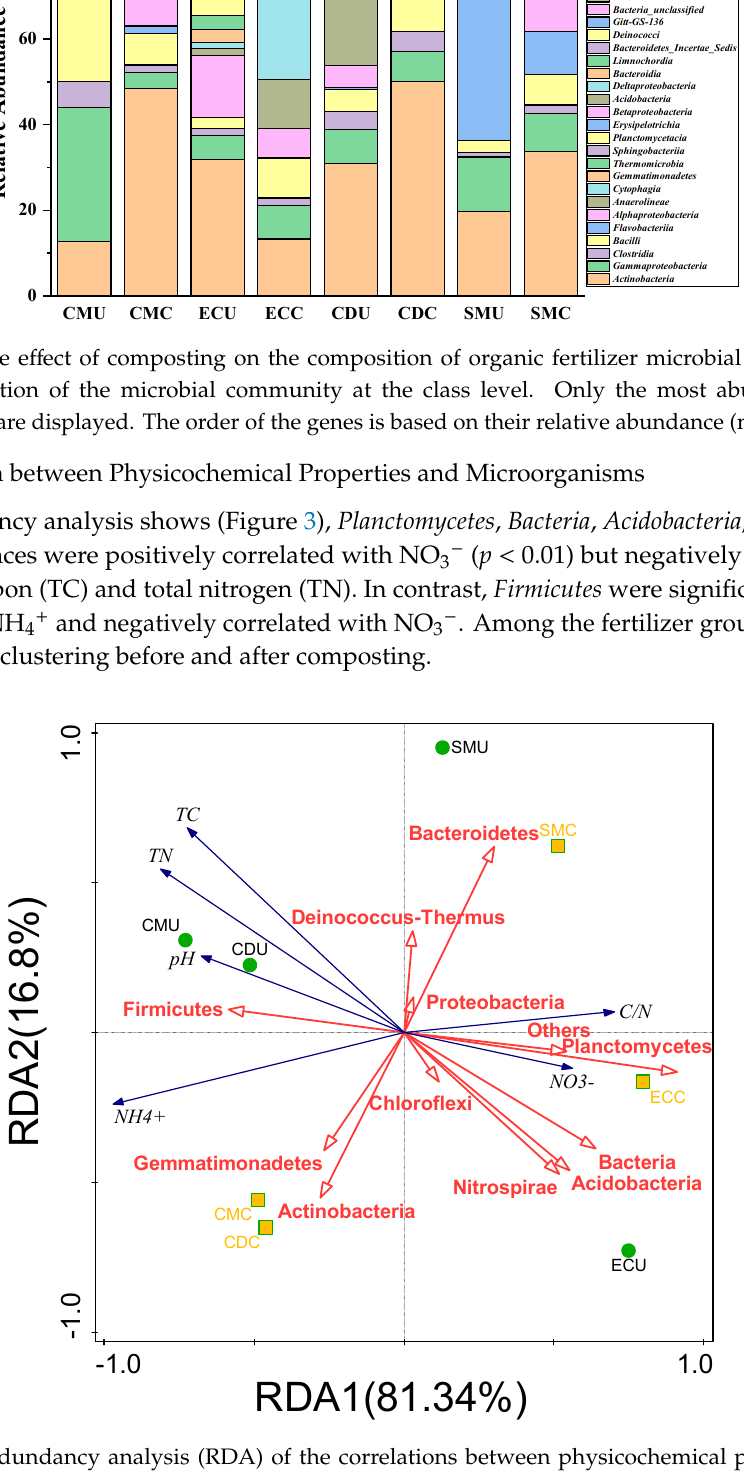
Figure 3. Redundancy analysis (RDA) of the correlations between physicochemical properties of organic fertilizer samples before and after composting and major microbial phyla ( > 1%) ( Actinobacteria, Firmicutes, Proteobacteria, Bacteroidetes, Chloroflexi, Gemmatimonadetes, Planctomycetes, Acidobacteria, Deinococcus-Thermus, Bacteria, Nitrospirae ). TN: total nitrogen; TC: total organic carbon.